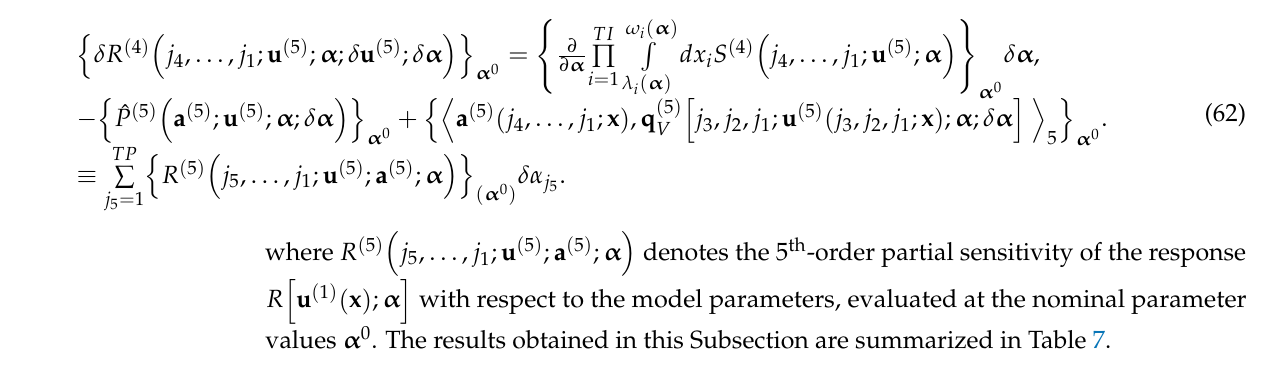
Table 7. Fifth-Order Sensitivities ( n =